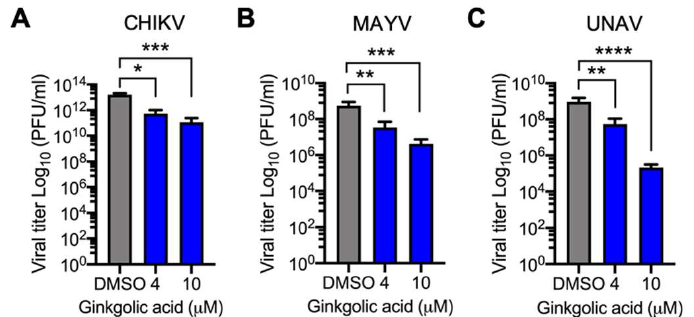
Figure 2. Ginkgolic acid’s effect on viral yield is concentration-dependent. Vero ( A ) and HeLa ( B , C ) cells were pre-treated with increasing concentrations of Ginkgolic acid and infected with CHIKV, MAYV or UNAV as previously described. After 24 h of incubation with the treatment or DMSO, production of infectious viral particles was quantified as previously described. Viral titers were represented as plaque-forming units per milliliter (PFU/mL). Experimental data were analyzed with the One-way ANOVA Test. Statistically significant differences are shown: *p < 0.05; **p < 0.01; ***p < 0.001; ****p < 0.0001.